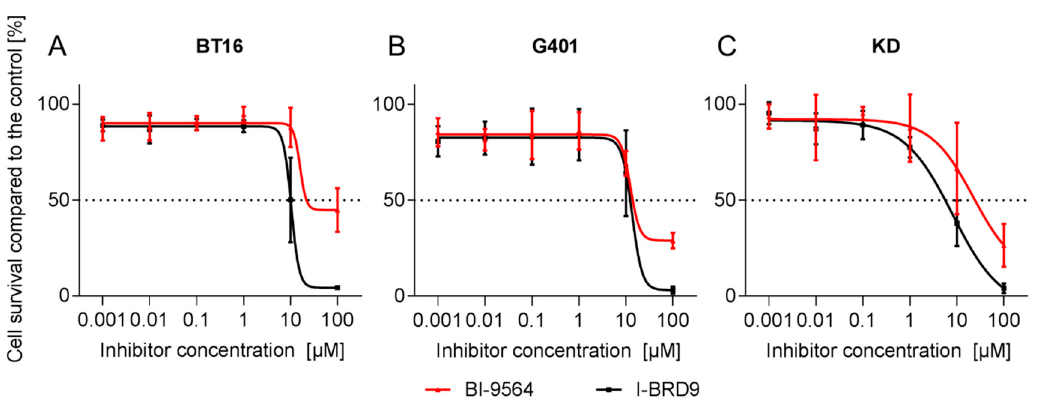
Figure 1. Proliferation curves of rhabdoid tumor (RT) cell lines BT16 ( A ), G401 ( B ) and KD ( C ) incubated for 72 h at different BRD9 inhibitors tested, BI-9564 (red) or I-BRD9 (black) concentrations based on MTT proliferation assays. Dotted line indicates 50% cell survival compared to the control. ( n ≥ 3; data are presented in means ± SD). Table 1. Half maximal inhibitory concentrations (IC 50 ) of BI-9564 and I-BRD9 in RT cell lines incubated for 72 or 144 h. Cell proliferation was evaluated by MTT cytotoxicity assays. ( n ≥ 3). IC 50 ( µ M)